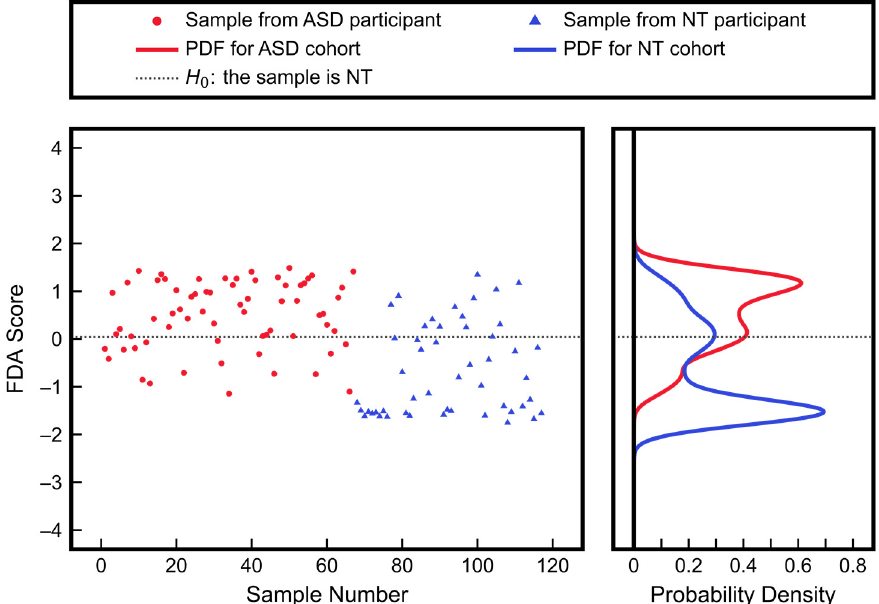
Figure 7. Results of classification using nonlinear KFDA with three urine toxic metal measurements (aluminum, cesium, tungsten) as inputs. KFDA scores were from leave-one-out cross-validation and the PDFs were obtained by fitting to the scores. The corresponding Type I and Type II errors are 29% and 28%, respectively.